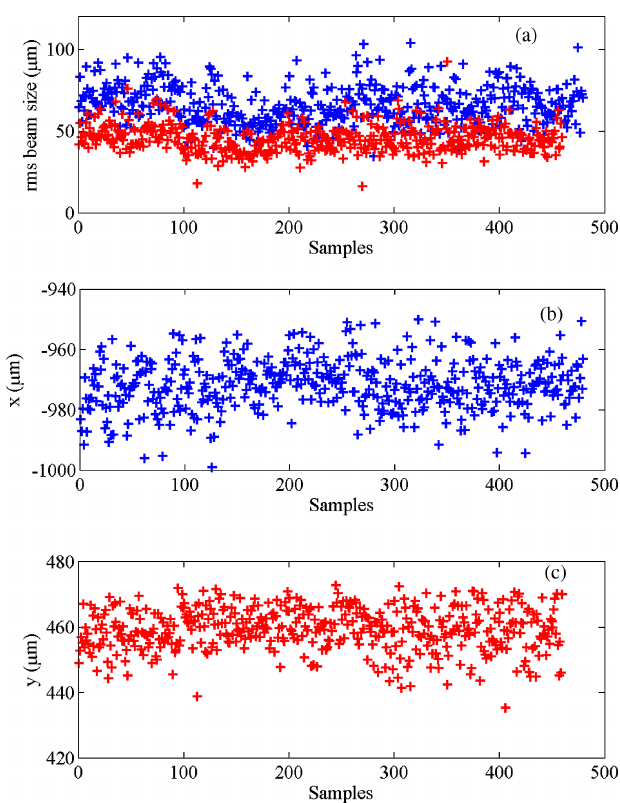
FIG. 32. Transverse stability of the electron beam measured on 500 consecutive shots (during a 50 second period with a 10 Hz pulse rate). (a) Vertical, in red, and horizontal, in blue, rms beam sizes, (b) horizontal position and (c) vertical